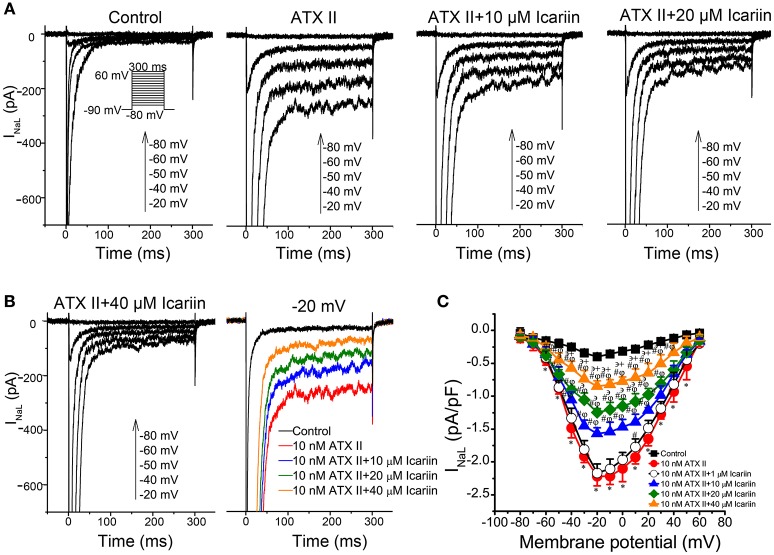
Effects of icariin on ATX-II-induced increases in INaL in LVMs. (A). Representative current recordings of INaL in LVMs after sequential treatments with 10 nM ATX-II and 10, 20, and 40 μM icariin. (B). Representative current recordings of INaL at −20 mV from (A,C). The current-voltage relationship of INaL in LVMs, n = 6 cells/4 rabbits. *p < 0.05 vs. control; #p < 0.05 vs. 10 nM ATX-II; φp < 0.05 vs. 1 μM icariin; ϶p < 0.05 vs. 10 μM icariin; +p < 0.05 vs. 20 μM icariin.